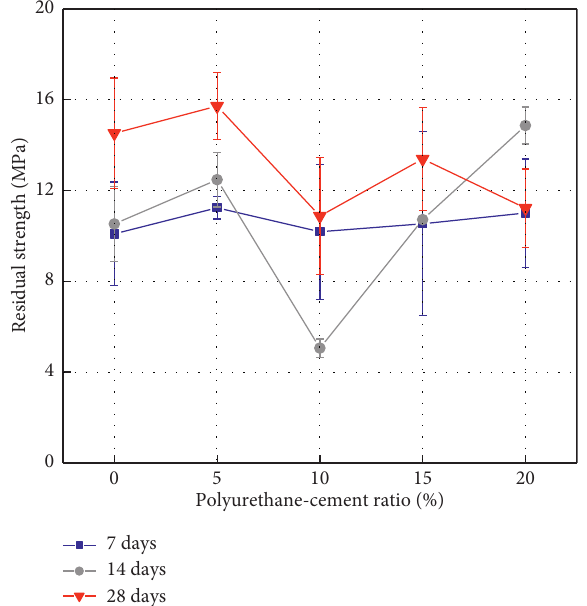
Figure 7: Variations of residual strength of PFCBCM versus mass content of polyurethane.